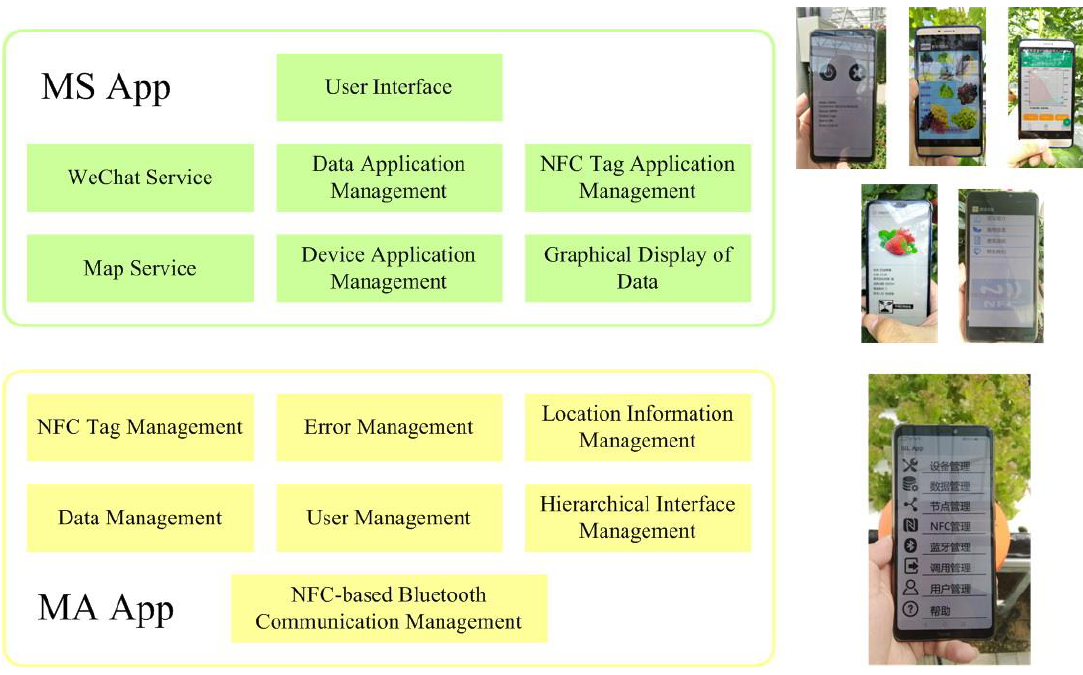
Figure 6. MA App and MS App.